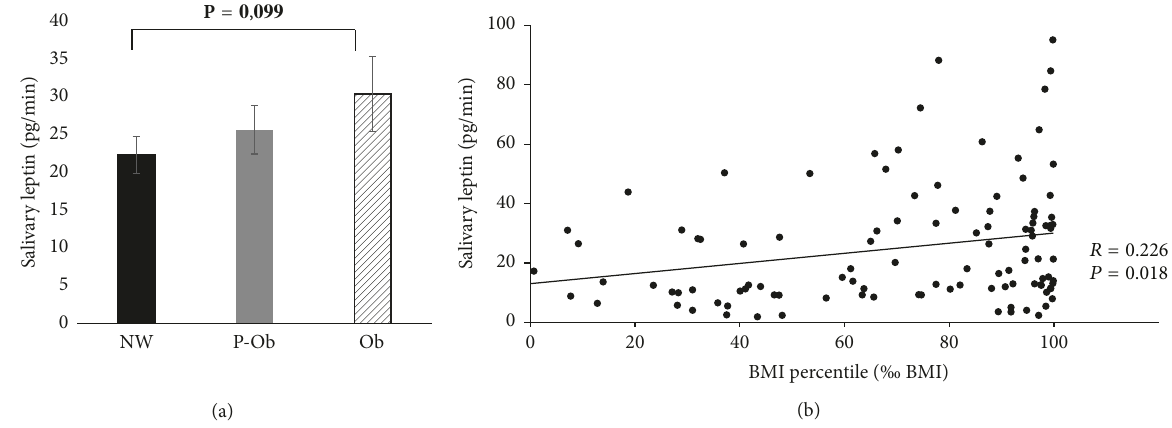
Figure 1: Salivary leptin levels according to ‰ BMI [(a) leptin (pg/min) mean ± standard error for normal weight (NW), preobese (P-Ob), and obese (Ob) children; (b) Spearman correlation between salivary leptin and ‰